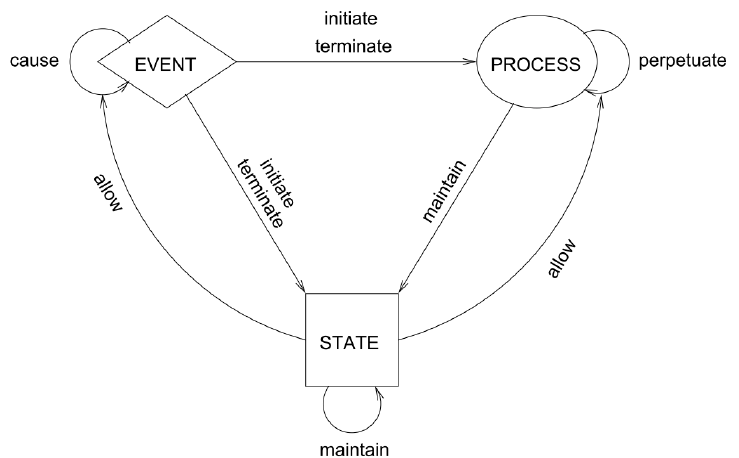
Figure 20. Causal and causal-like dependencies amongst states, processes, and events [102] .